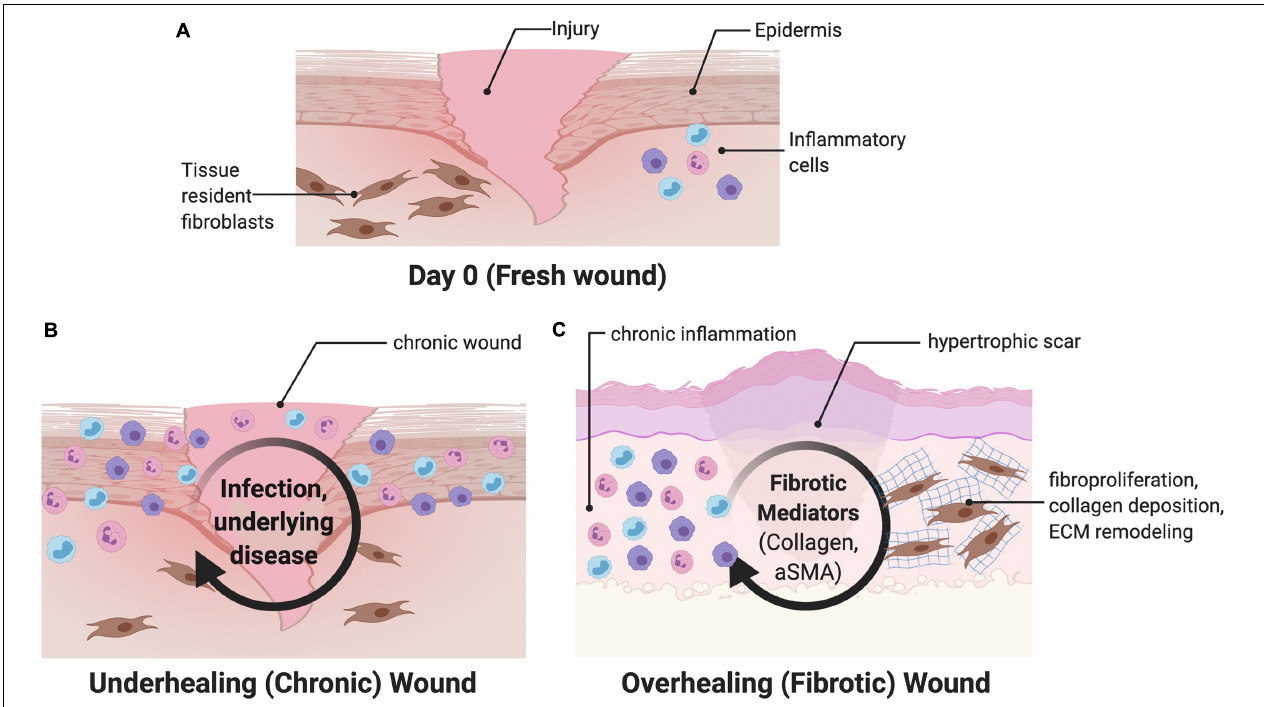
FIGURE 2 | Overview of wound healing. (A) After an initial wound, both circulating and tissue resident cells are recruited to the wound, including fibroblasts and inflammatory cells. (B) Chronic wounds are characterized by interruptions and subsequent prolongation of the wound healing process. (C) Fibrotic wounds are characterized by upregulation of myofibroblast differentiation and increased collagen production and may be driven by mechanical signaling. aSMA, alpha smooth muscle